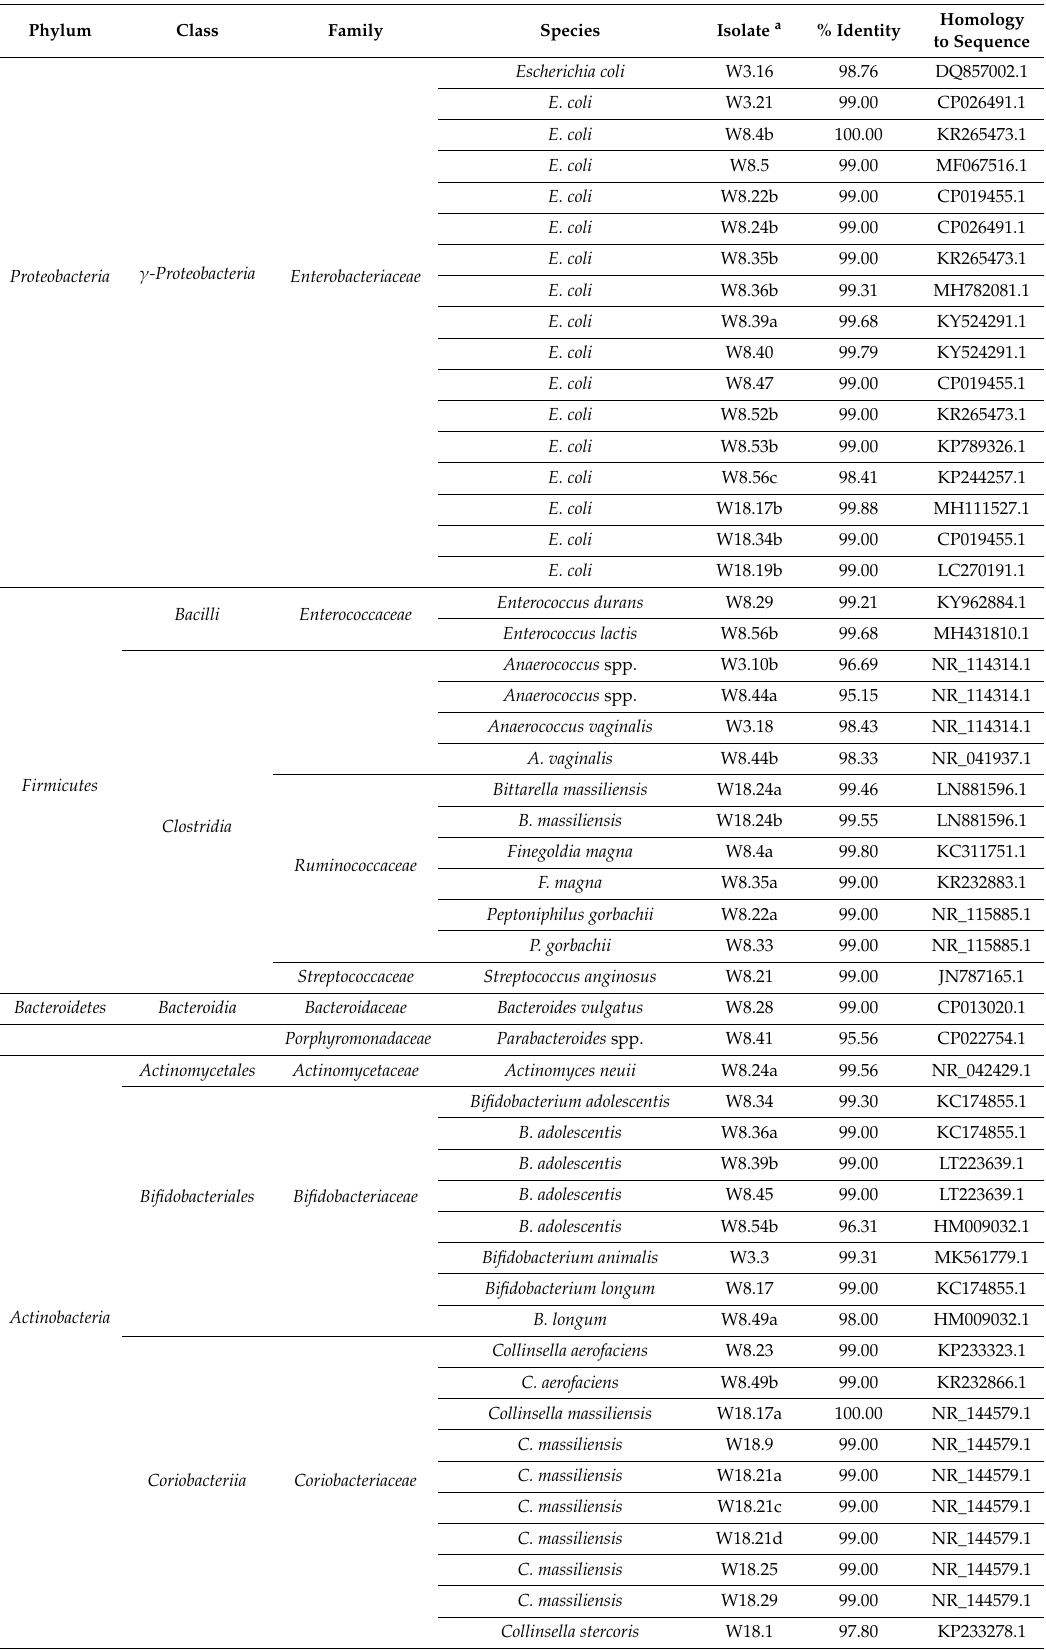
Table 1. Molecular identification by 16S rRNA gene sequencing of the isolates in this study.